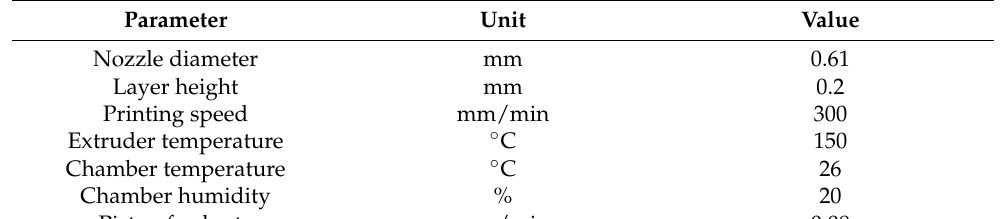
Table 3. Experimental parameters.